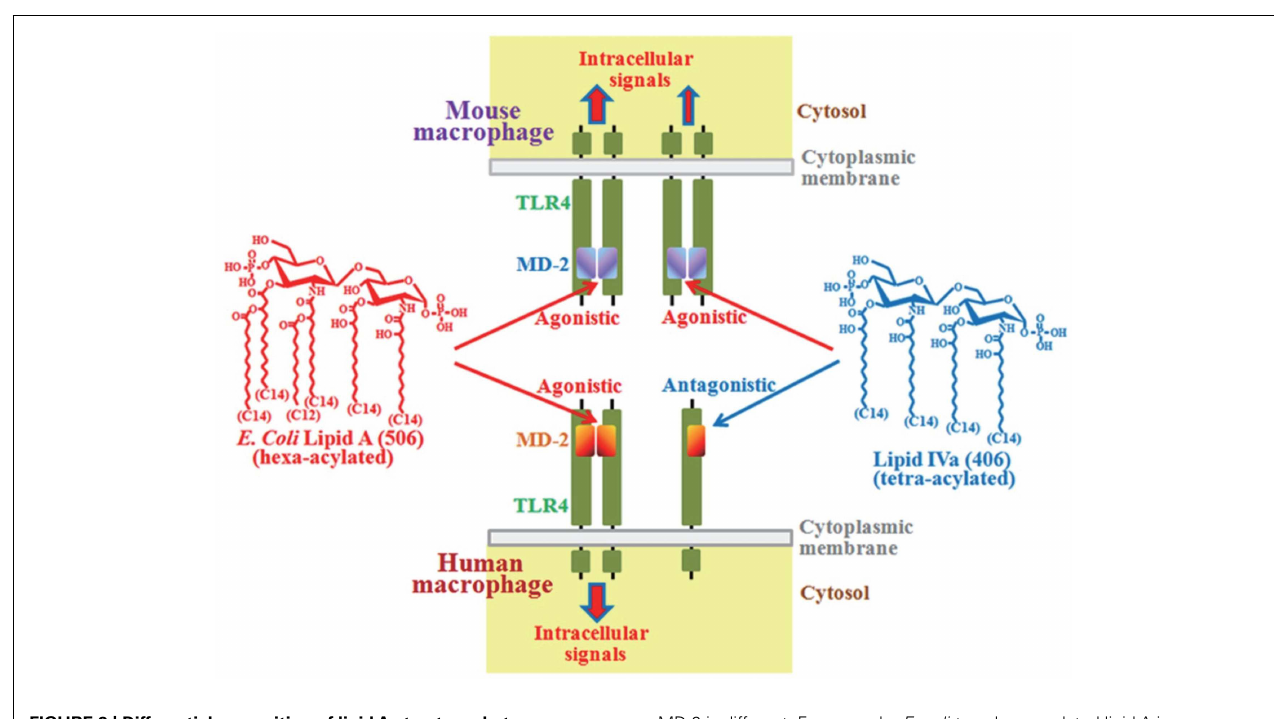
FIGURE 2 | Differential recognition of lipidA structures between human and mouseTLR4/MD-2 complexes .TLR4 is a type I transmembrane molecule, and MD-2 is an extracellular molecule that associates with the extracellular region ofTLR4. Lipid A can bind to MD-2 but not toTLR4. Binding of lipid A to MD-2 induces dimerization of theTLR4/MD-2 complex for transduction of stimulatory signals into cells. Recognition of lipid A structures by mouse MD-2 and human